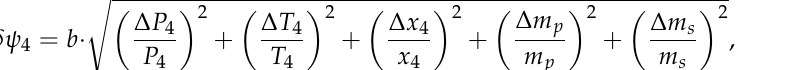
The estimated values are determined based on the specific exergy and mass flow rate. Estimated value by formulas (15) and